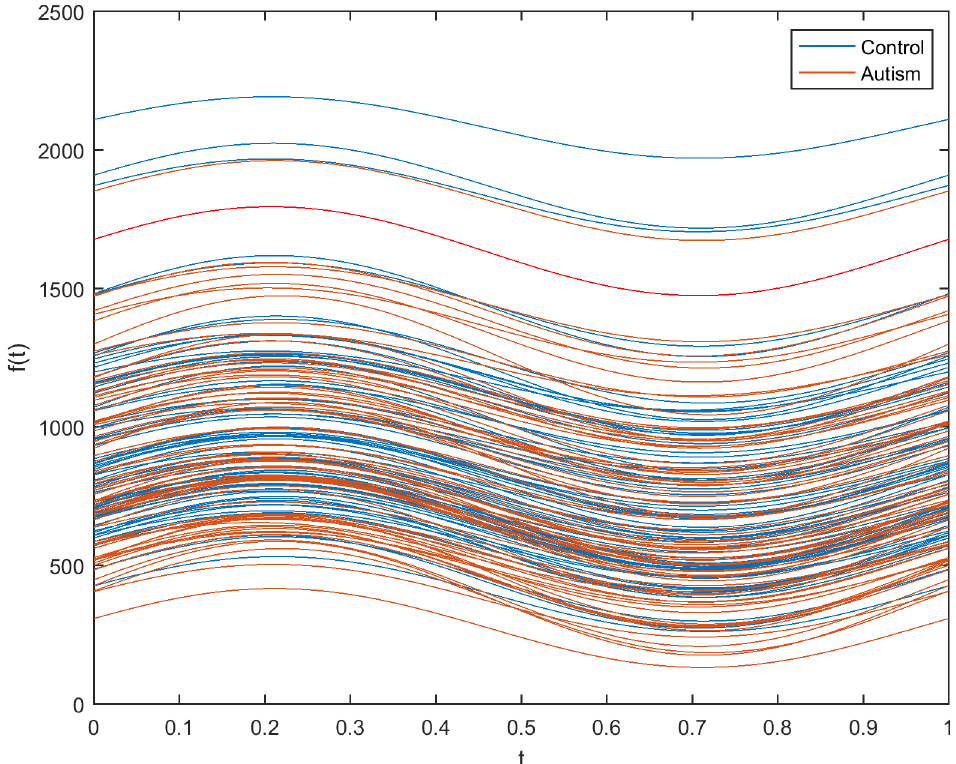
Fig 11. Andrews plot for three representative selected genes from the reduced dataset before the application of filter methods.